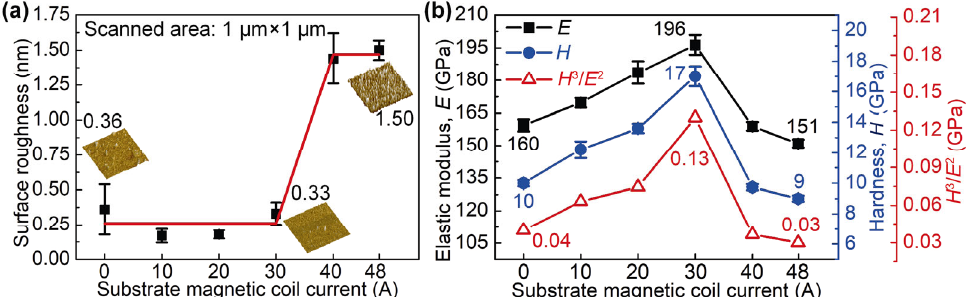
Fig. 3 Trends of (a) surface roughness and (b) elastic modulus ( E ), hardness ( H ), and ratio of H 3 / E 2 with I s , which is proportional to the resistance of the film to plastic